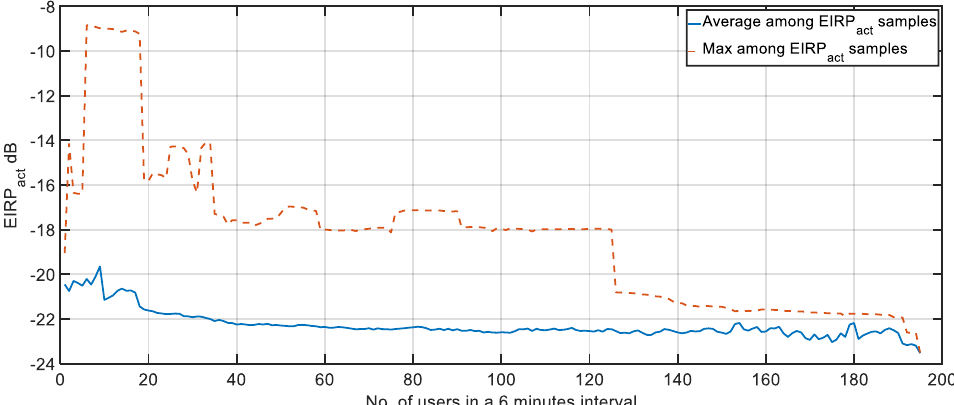
Figure 6. EIRP act as a function of the number of served users within the six-minute intervals. The red dashed line shows the maximum value among the EIRP act samples, while the blue solid line corresponds to the mean. EIRP act is normalized to the envelope of the theoretical maximum EIRP.